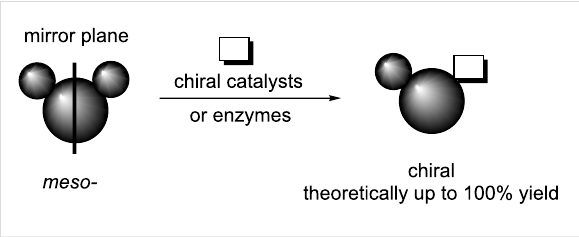
Figure 1: The catalyzed enantioselective desymmetrization.